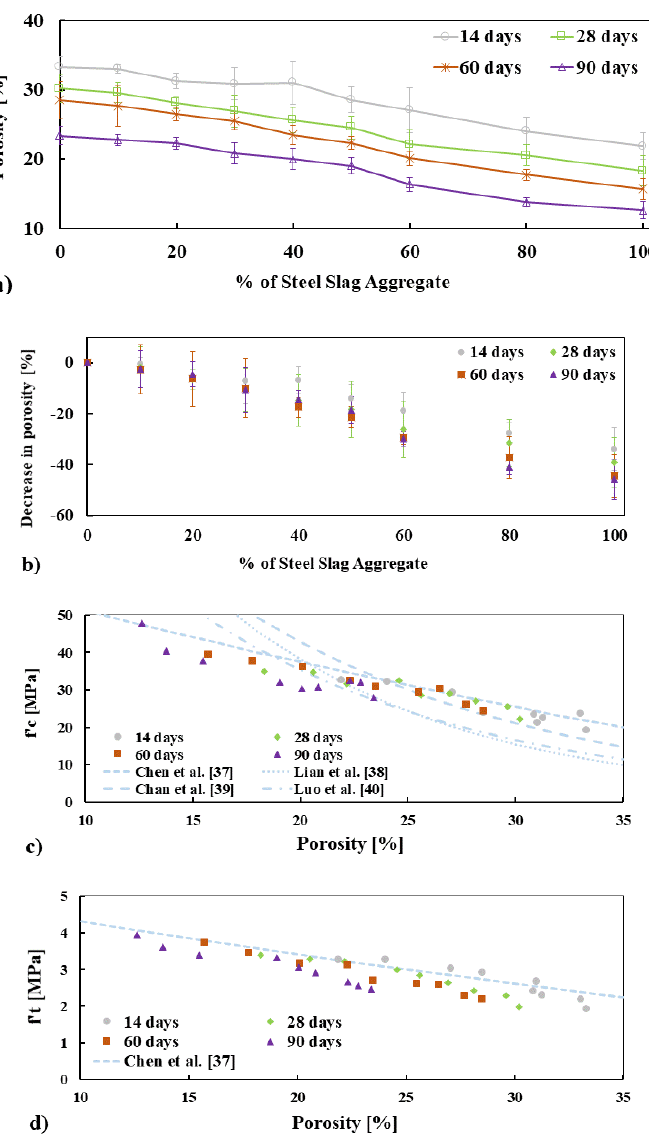
Figure 10. Apparent porosity ( a ), decrease in apparent porosity as a function of SSA ( b ), and the relation between 𝑓 𝑐′ and 𝑓 𝑡′ compared with different models/exponential relationships available in the literature ( c , d ), respectively.